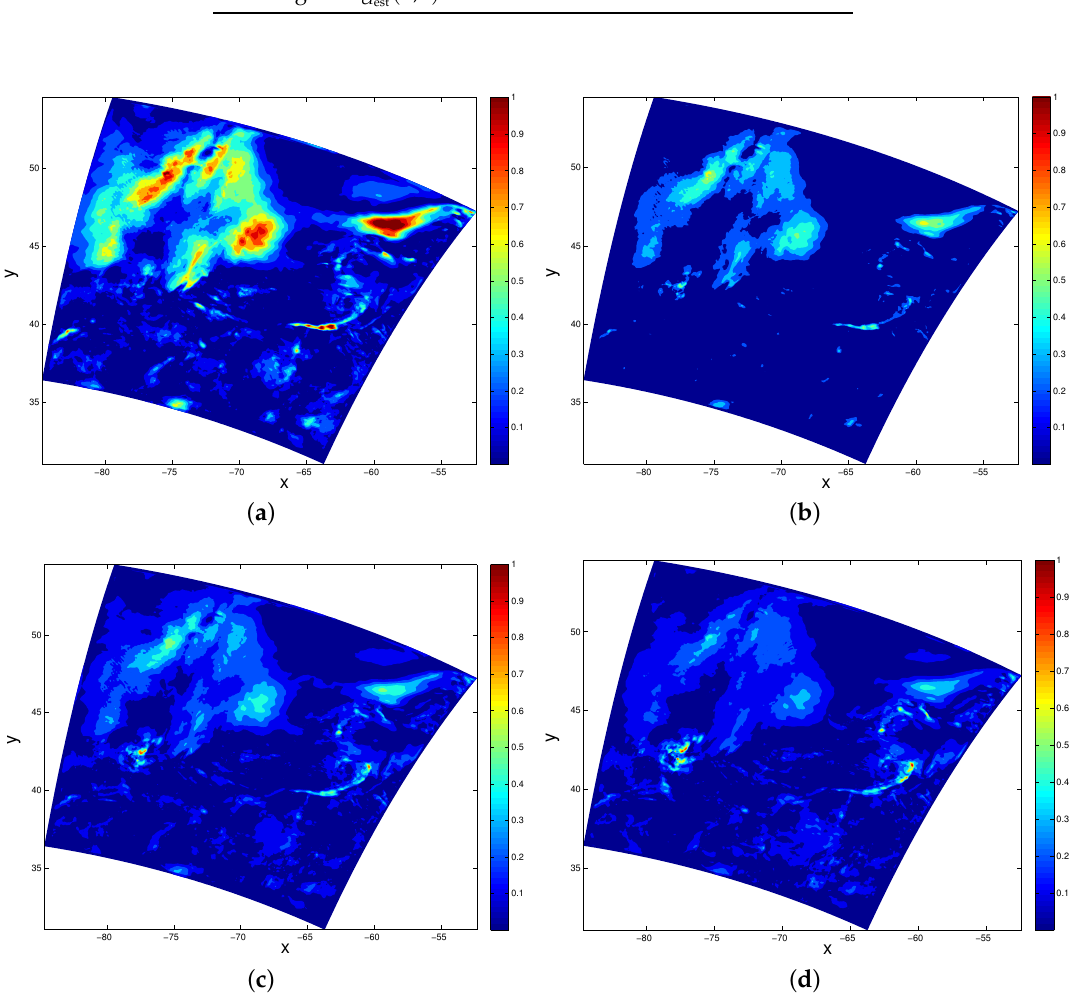
Figure 6. Standard deviation of the reconstructed snapshot 1 based on noisy measurement which does not depends on the wind field. ( a ) R = 0; ( b ) R = 0.5; ( c ) R = 1; ( d ) R =